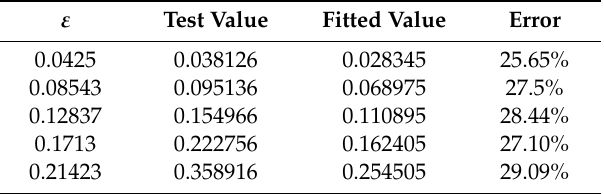
Table 16. The deviation between the test and calculated values for specimen 3 under 200 °C . 𝜺